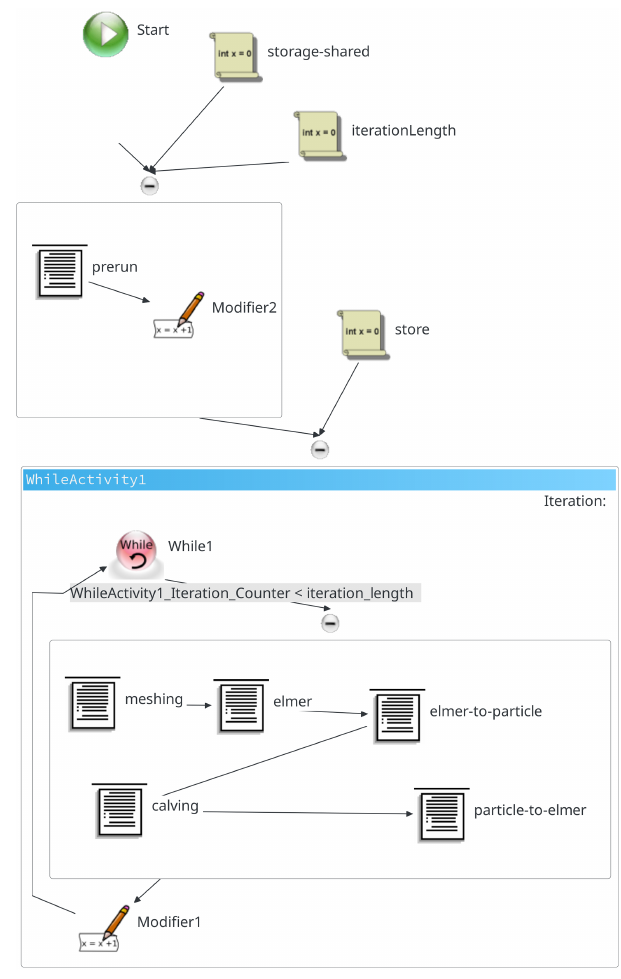
Figure 4. Workflow implementation in the URC